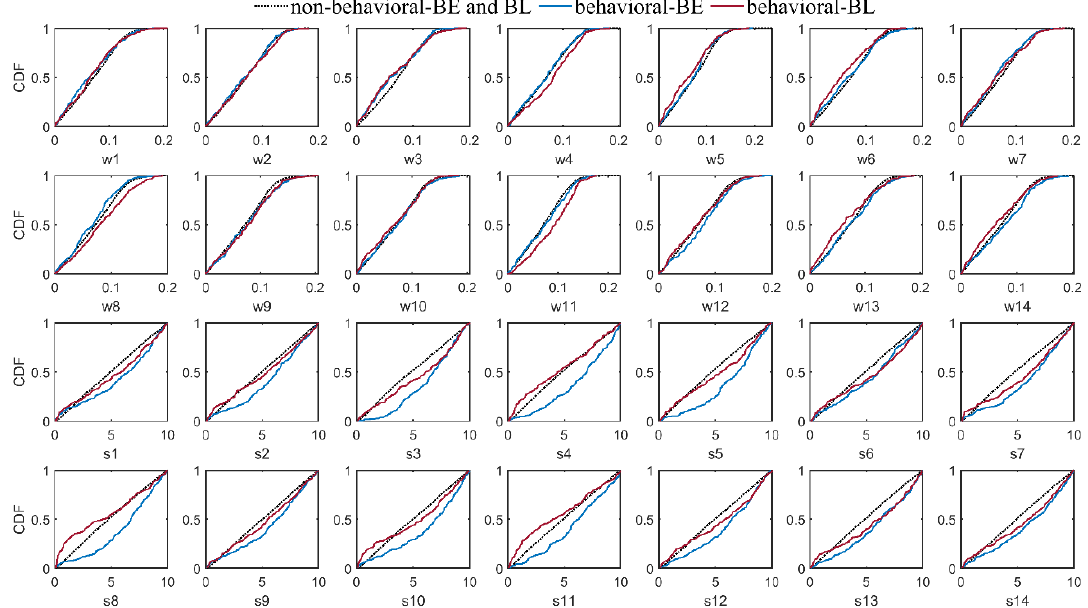
Figure 12. The RSA plots for the parameters of the C1V2T0 BMA variant for both the Big East River and Black River watersheds.